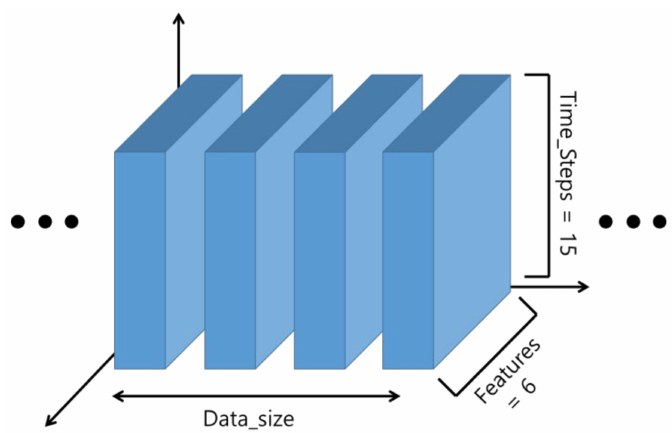
Figure 8. A three-dimensional array of LSTM’s